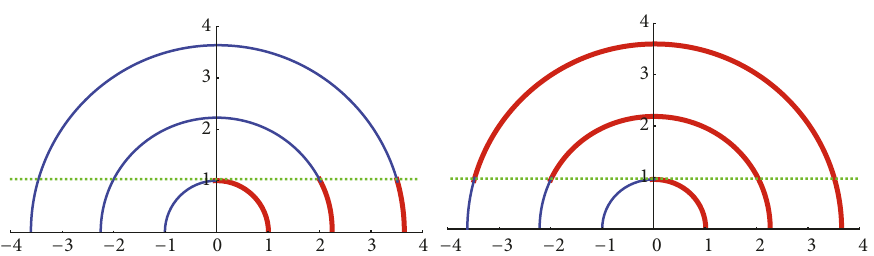
Figure 6: We have shown here various string profiles in {𝑧,𝑥} -plane. The vertical axis is the 𝑧 -axis and the horizontal axis is the 𝑥 -axis. The left diagram corresponds to 𝑡 < 0 and the semicircular profiles shrink as time increases towards positive values. On the right, we have 𝑡 > 0 and the semicircular profiles grow as time increases. In both, the advanced solution is denoted by the blue, thin curve and the retarded solution is represented by the red, thick curve. The green horizontal dashed line corresponds to the worldsheet event horizon, located at 𝑧 have taken these diagrams from [50], with the authors’